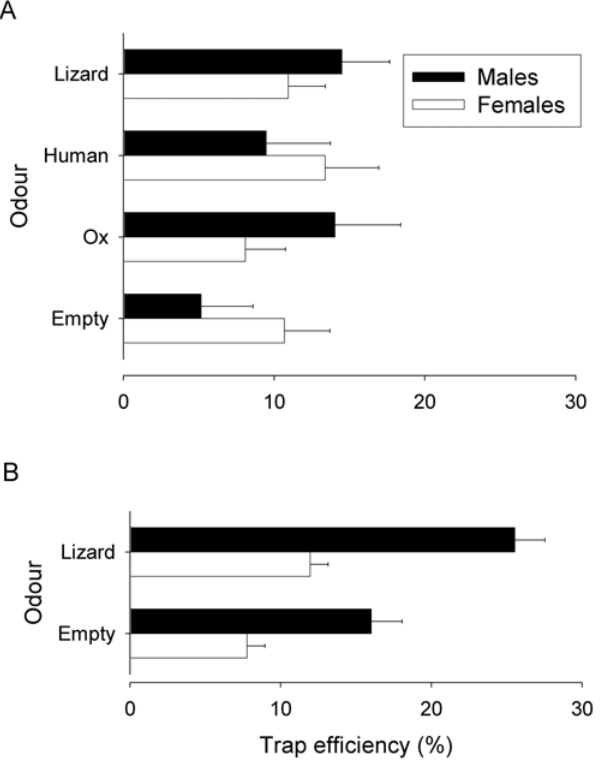
Figure 3. Effect of mammalian (A) and lizard (A & B) host odours on trap efficiency. Trap efficiency was gauged by expressing the mean catch of G. f. fuscipes caught in a trap alone as a percentage of the total catch from the trap + flanking